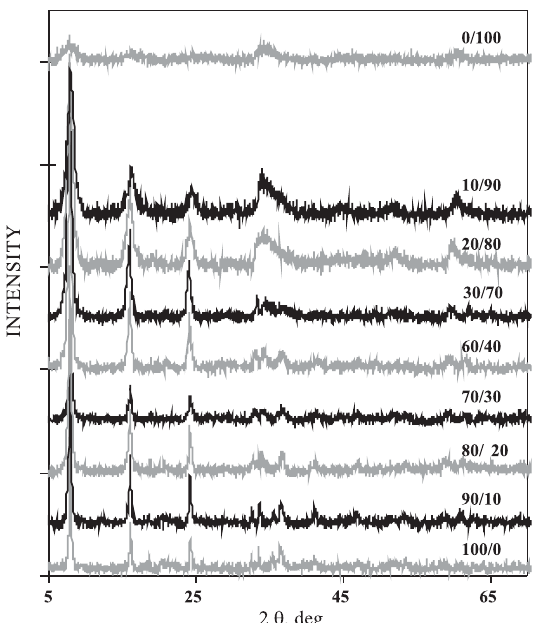
Figure 1. X ray diffraction patterns of the initial Ni(II)-GR2 products obtained in anoxic conditions as a function of the Fe(II)/Ni(II) ratio of the